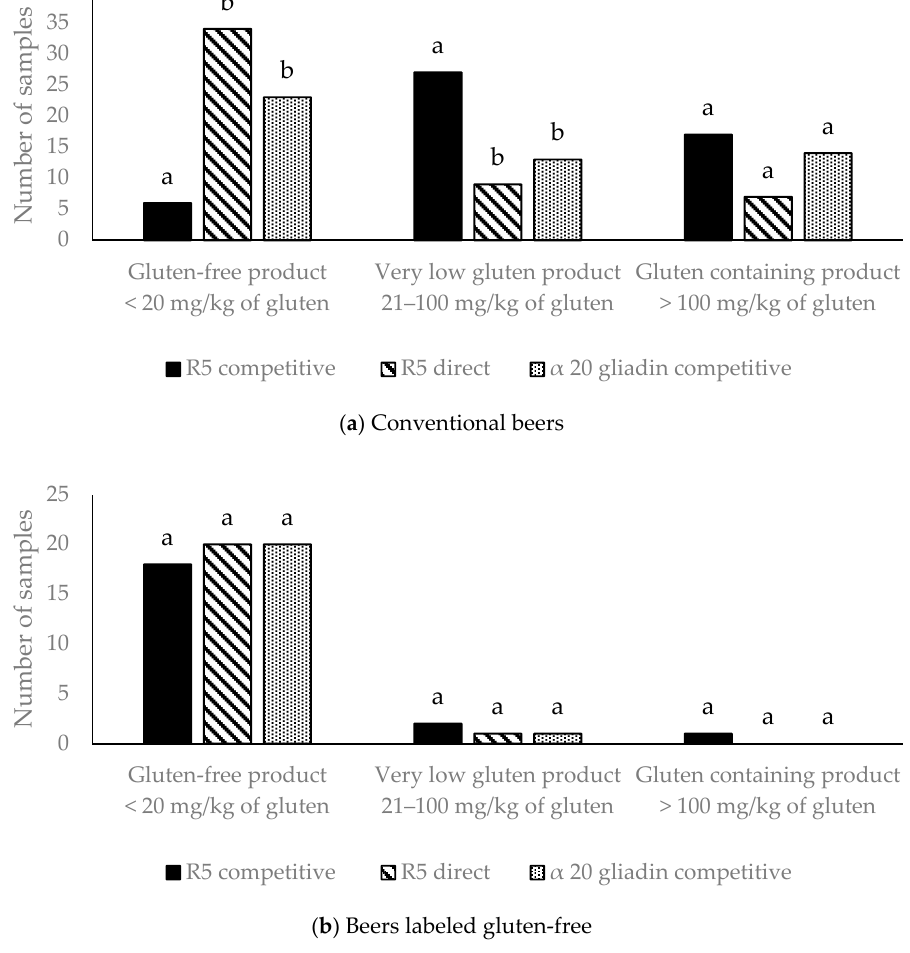
Figure 1. Number of ( a ) conventional beers and ( b ) beers labeled gluten-free from the cohort in each gluten threshold according to Codex standard [16] and European legislation [11] resulting from the analysis performed with three commercial ELISA kits used. Analysis was performed with the chi-square test. Bars with different superscript letters are significantly different ( p < 0.05).